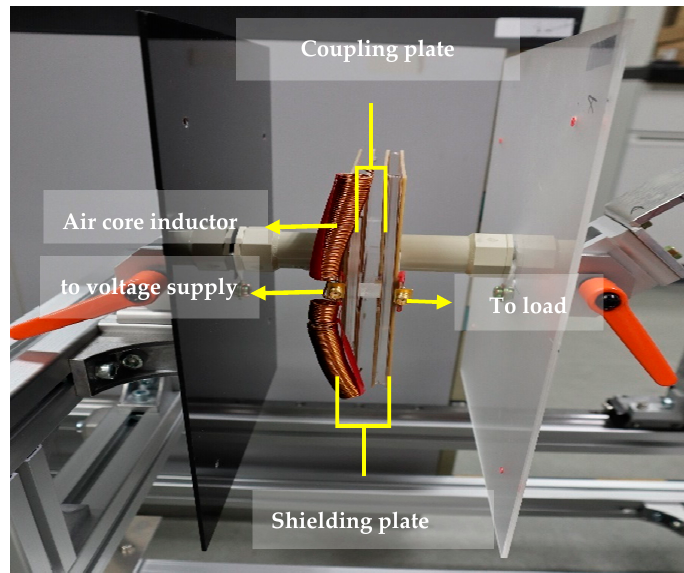
Figure 17. Experimental setup for S-CPT system.